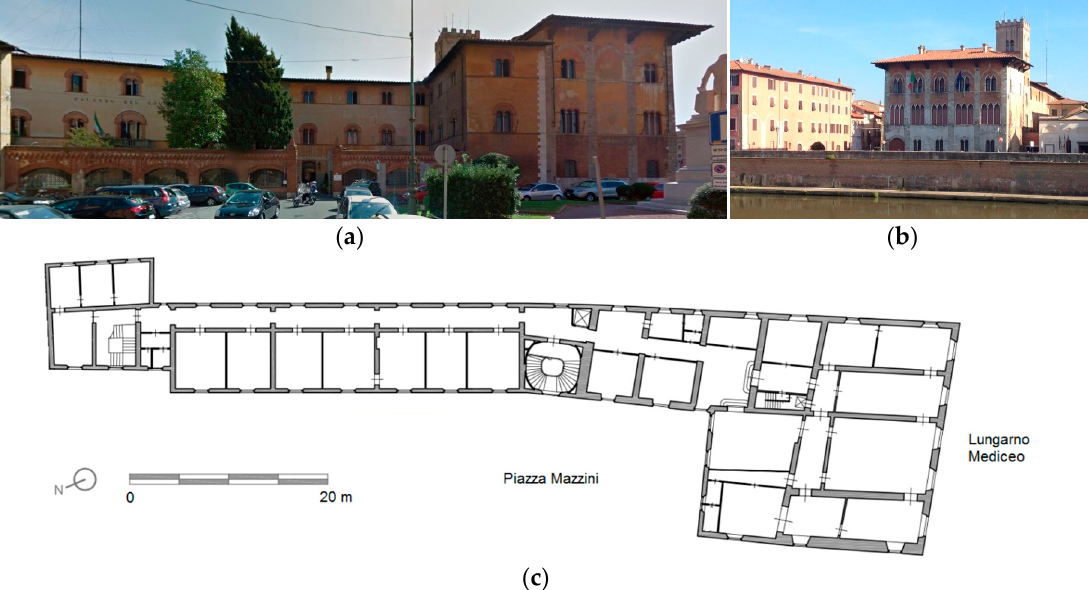
Figure 2. Palazzo Medici in Pisa: ( a ) Western front view; ( b ) Southern front view; and ( c ) A schematic plan of the second floor.